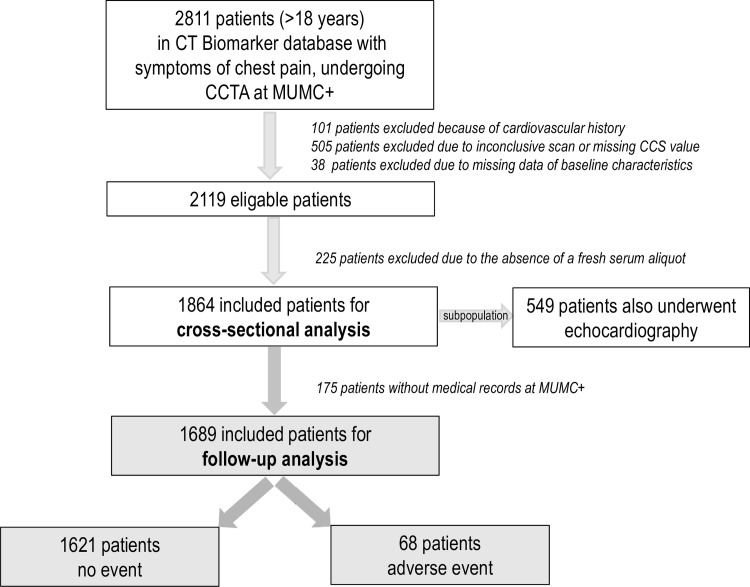
Flow chart of included and excluded patients.